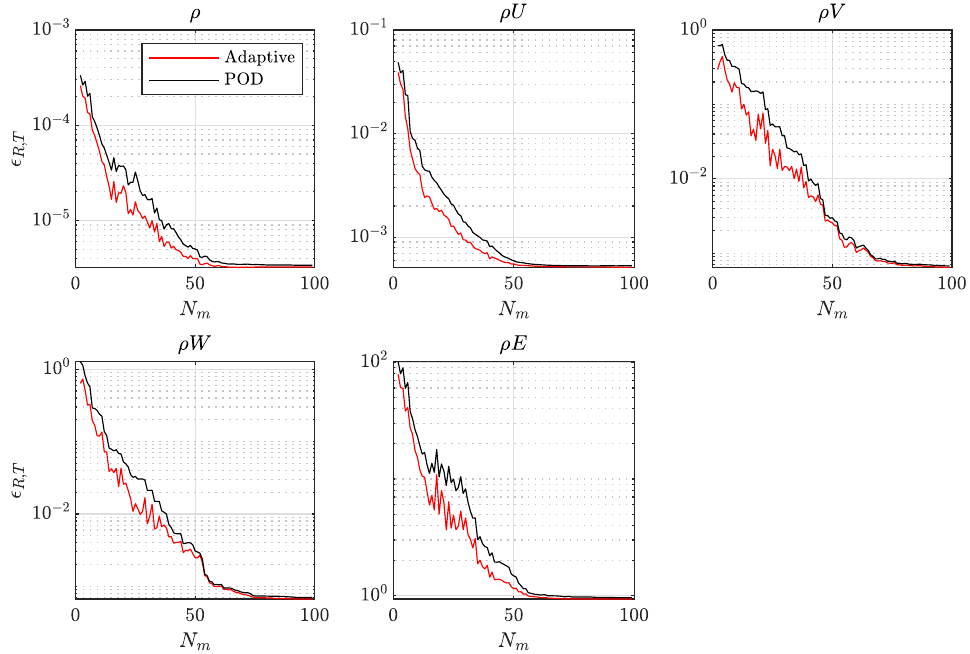
Figure 20. The log 10 ( (cid:101) R,T ) varying the number of modes, for adaptive ROM and POD, formation flight test case.